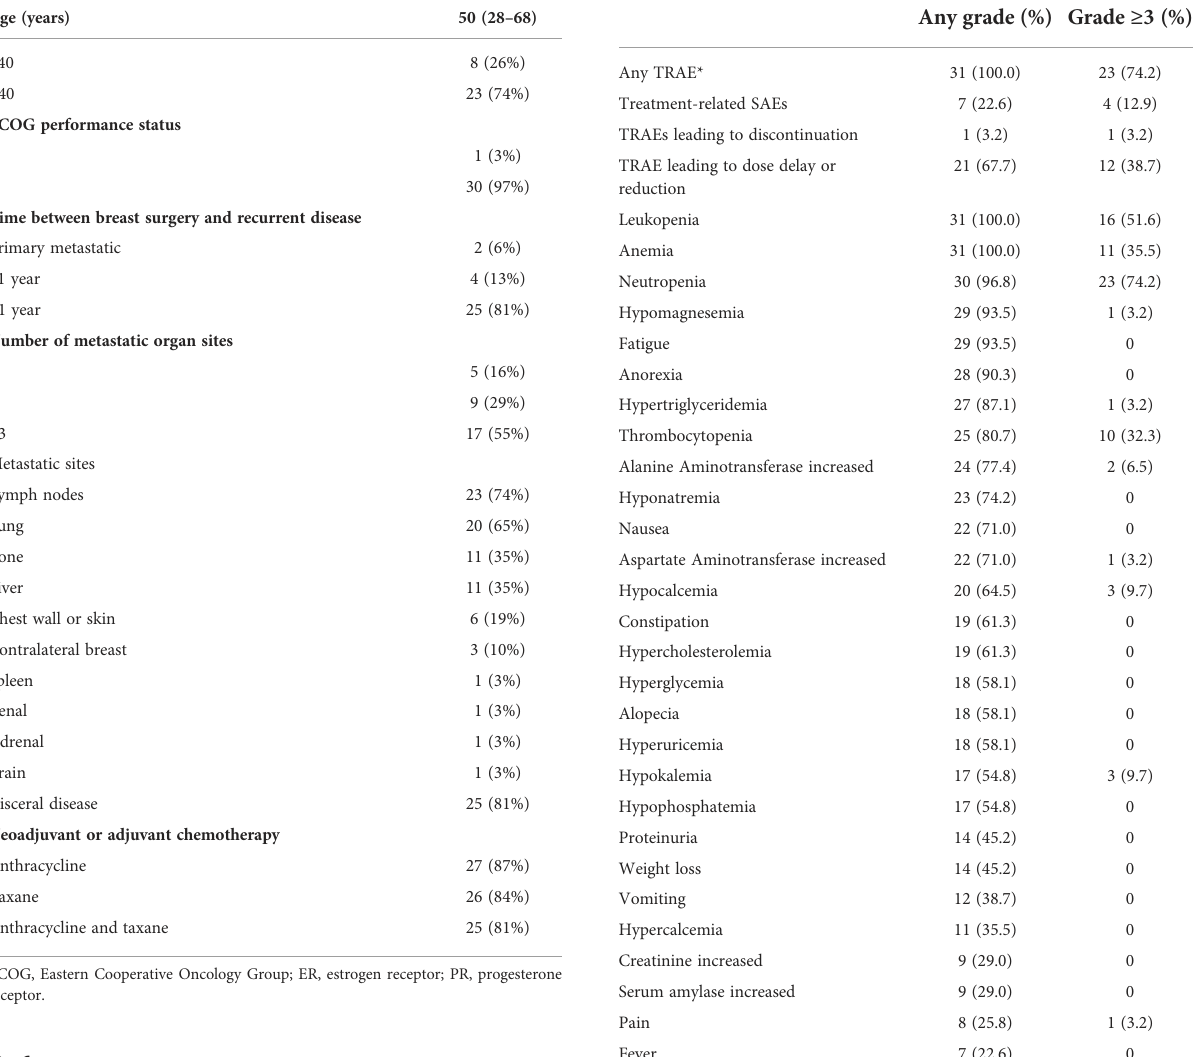
TABLE 1 Baseline patient characteristics. TABLE 2 TRAEs of any grade occurring in ≥ 10% of patients.